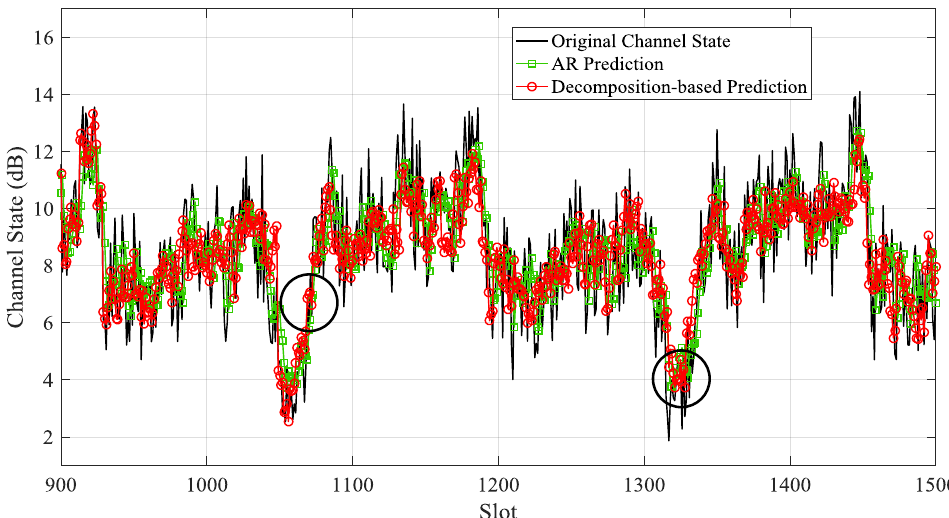
Figure 19. Predicted small-scale channel state of Data 2 by the decomposition-based prediction model and AR